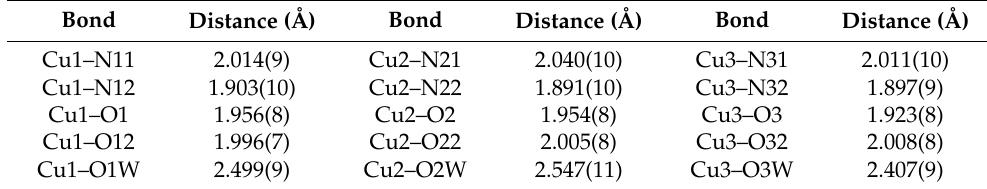
Figure 1. ORTEP-type diagram of the asymmetric unit of Cu–AlaLeu with 50% probability ellipsoids. The hexafluorophosphate anion and the hydration water molecule are omitted for clarity. The atom numbering scheme for coordinating atoms is included. Atom color code: C (gray), O (red), N (blue), Cu (orange) and H (white). Table 1. Coordinative bond distances.